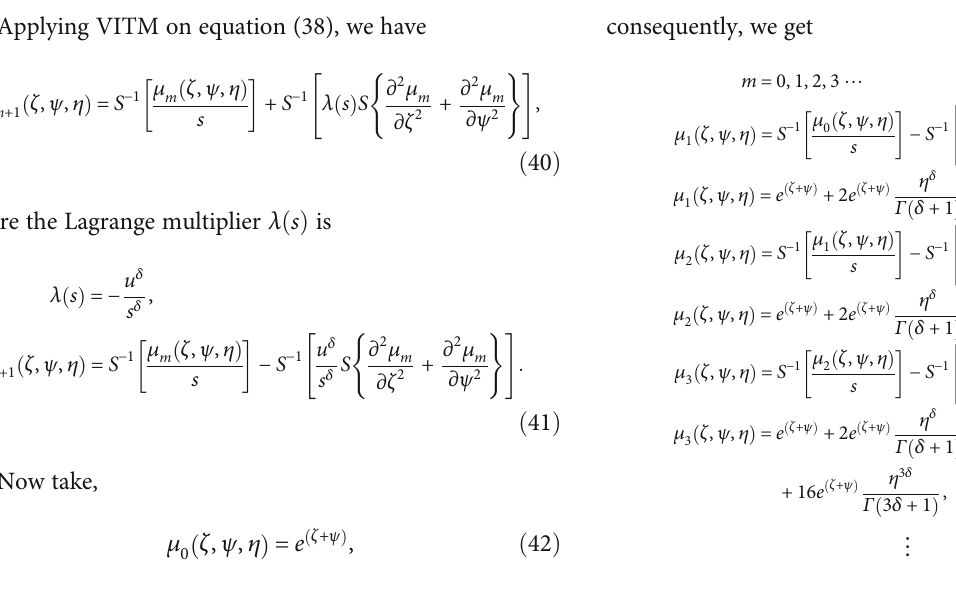
Figure 2: The di ff erent fractional-order graphs of Problem